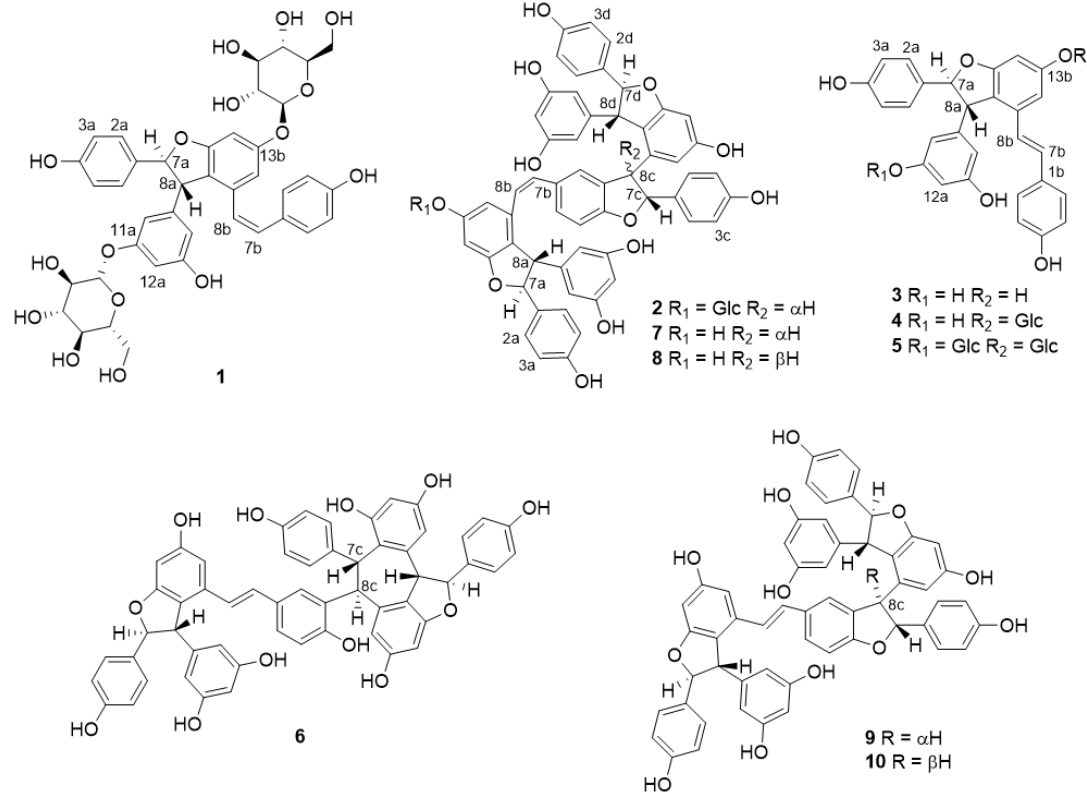
Figure 4. Structures of isolated stilbene oligomers from I. lactea var. chinensis .